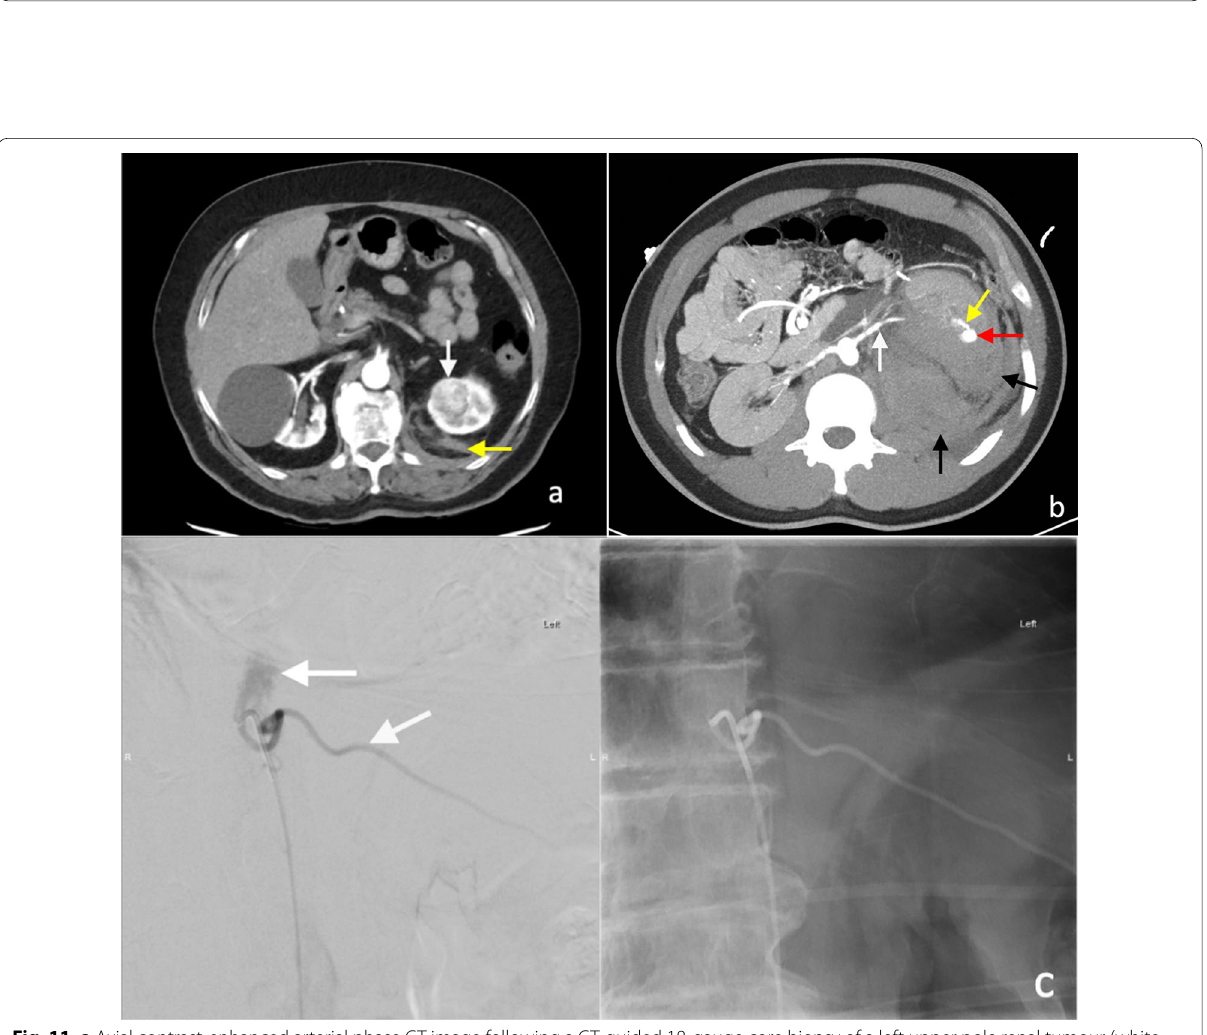
Fig. 11 a Axial contrast-enhanced arterial phase CT image following a CT-guided 18-gauge core biopsy of a left upper pole renal tumour (white arrow) with adjacent perinephric haematoma and stranding (yellow arrow). b A more superior arterial phase axial CT image in the same patient demonstrated active extravasation of contrast (white arrow) within the small left haemothorax (yellow arrow) from a left intercostal artery at T11 (red arrow). c Active contrast extravasation (white arrow) from a left T11 intercostal artery (yellow arrow) was confirmed on angiography and successfully treated with embolisation